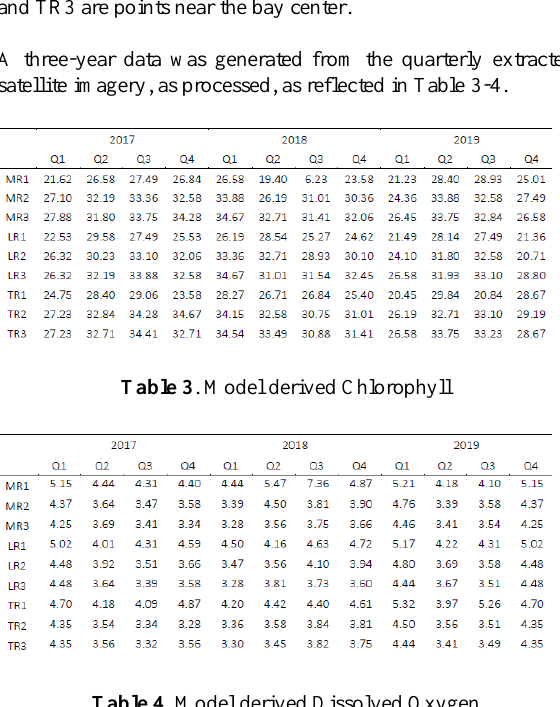
Table 4 . Model derived Dissolved Oxygen Figure 10. Dissolved Oxygen Shore